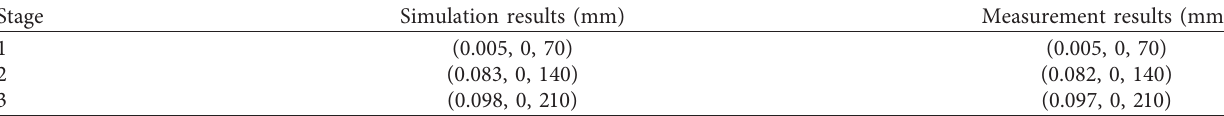
Table 1: The centroid coordinates of the top surface of the assembled 3-stage rotor.